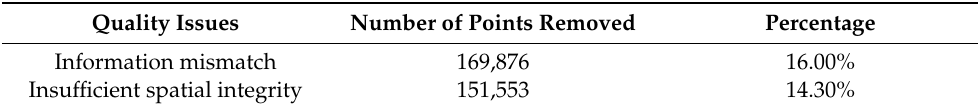
Table 3. Trajectory integrity repair results.